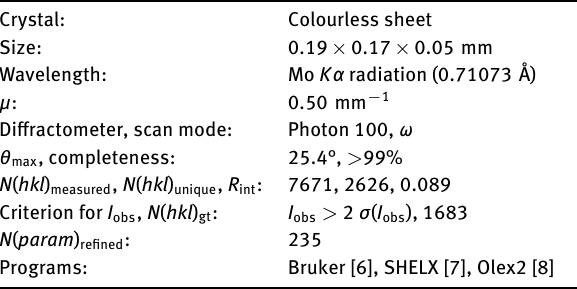
Table 1: Data collection and handling.